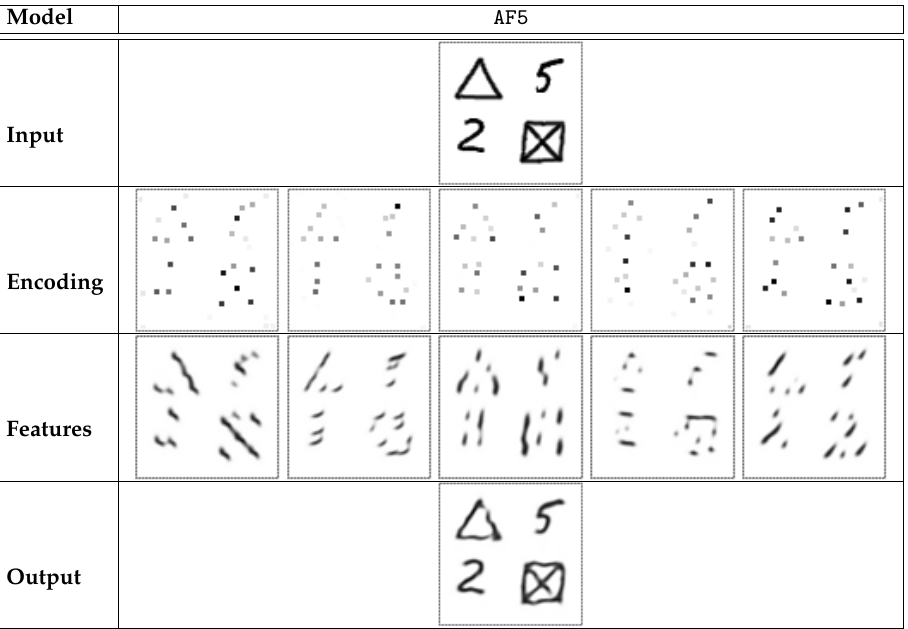
Figure 13. Sample encoding of a larger image that contains both digits and other symbols, performed with the AF5 model. The presented feature-specific decodings were generated in the same way as those shown in Figure 8.